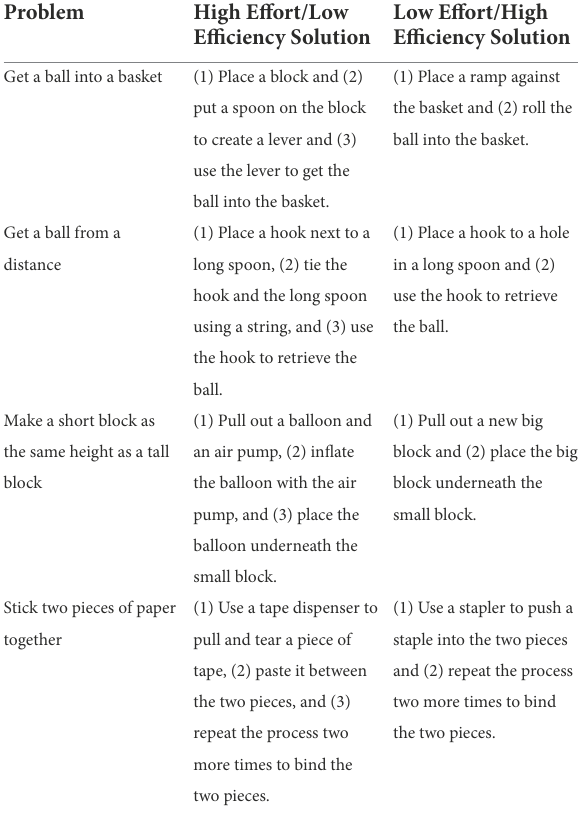
TABLE 1 Problems and solution action sequences during the familiarization phase.